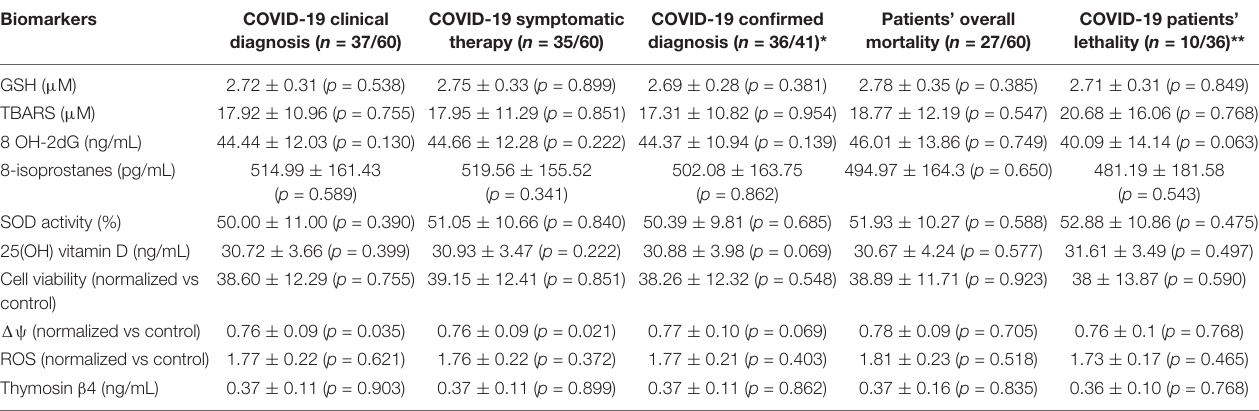
TABLE 4 | Association between patients’ levels of oxidative stress markers at baseline and patients’ outcomes at follow-up (Mann–Whitney U test, mean ± SD, significant at 0.05 level). Biomarkers COVID-19 clinical COVID-19 symptomatic COVID-19 confirmed Patients’ overall COVID-19 patients’ diagnosis ( n = 37/60) therapy ( n = 35/60) diagnosis ( n = 36/41)* mortality ( n = 27/60) lethality ( n = 10/36)**